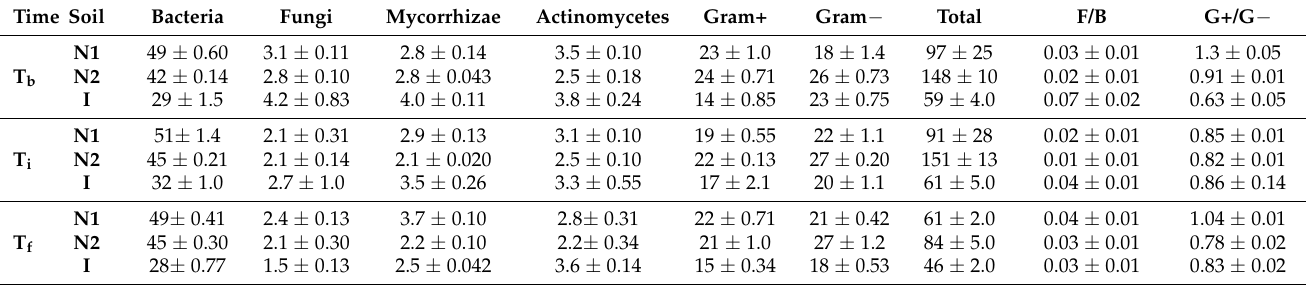
Table 2. Microbial groups in each soil system (N1, N2, I) at each sampling time (T b , T i , T f ), expressed as mean values ± standard errors in respect to the total microbial biomass